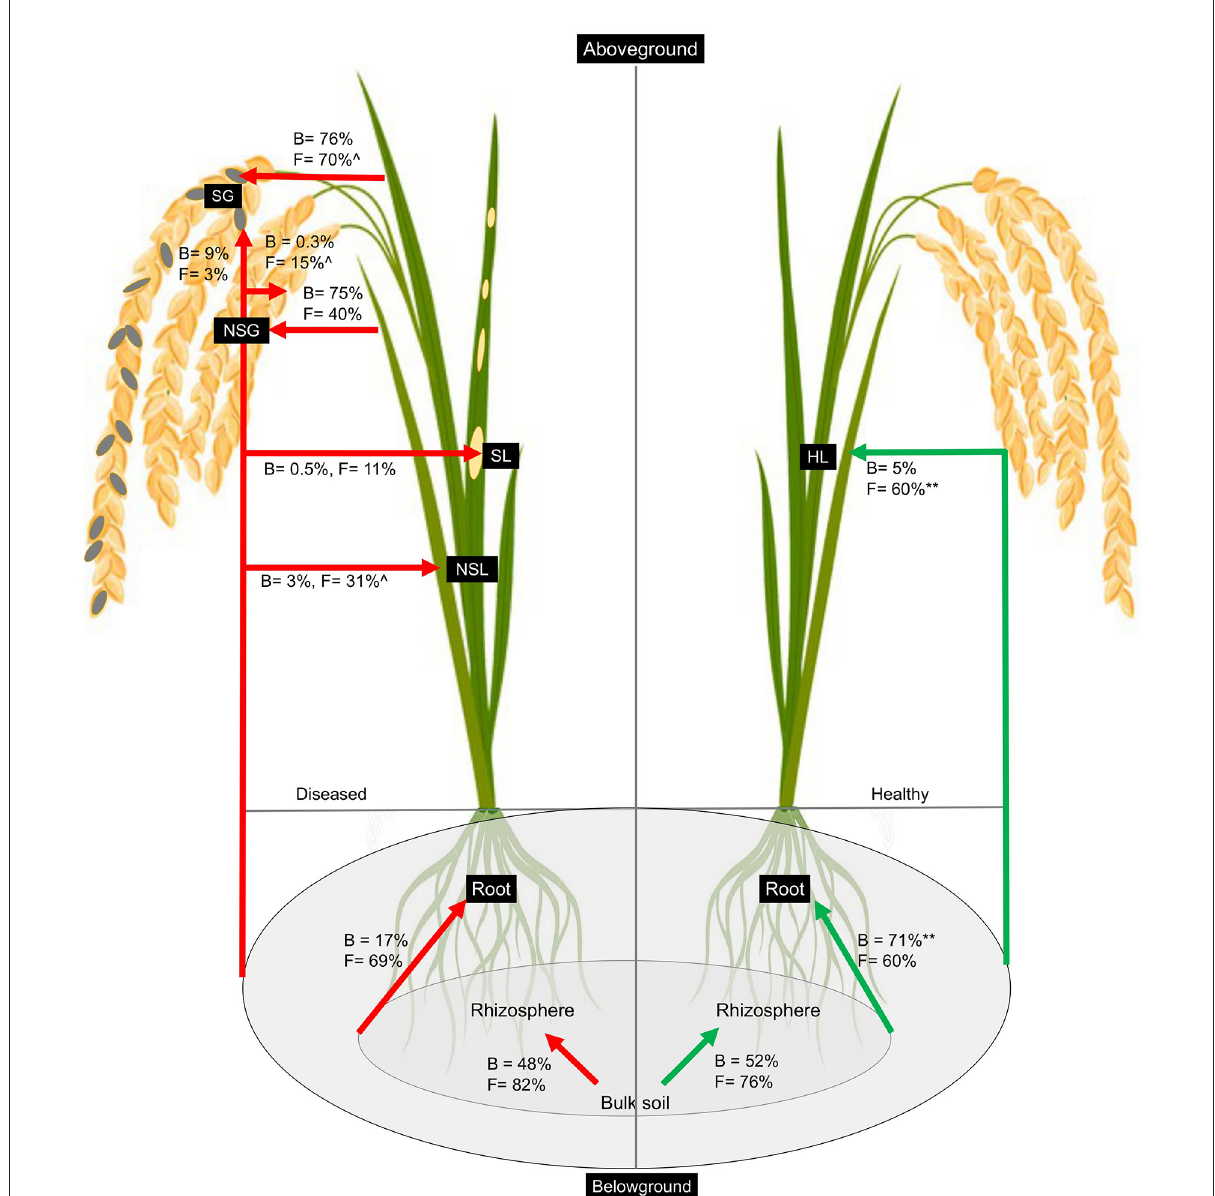
FIGURE5 Percentage of bacteria and fungi in each sample that was associated with source types as determined by SourceTracker. The asterisk ( ** ) indicates significant higher percentage at p < 0.01 in healthy as compared to diseased samples whereas caret ( ∧ ) indicates higher percentage at p < 0.05 in non-symptomatic tissues as compared to symptomatic tissues of the diseased plants as obtained from Kruskal–Wallis